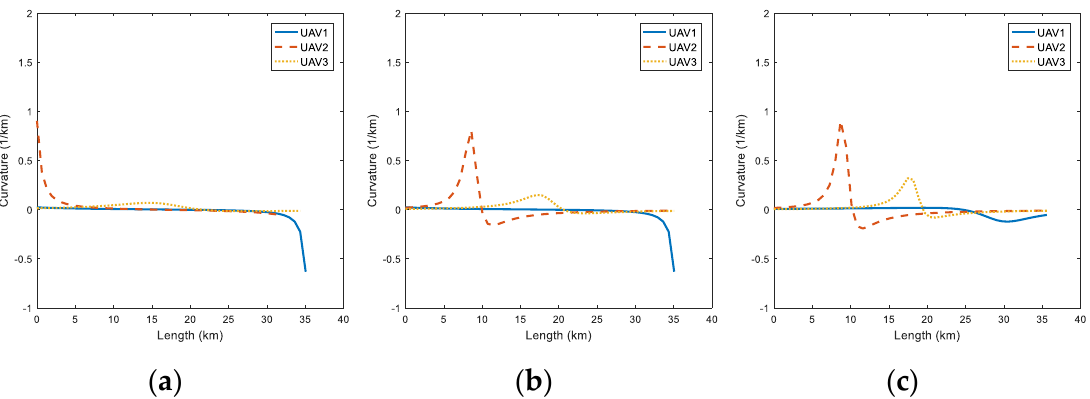
Figure 5. Curvature variations with respect to path length. (a) Produced by DCPSO without cooperation; (b) produced by DCPSO with cooperation; (c) produced by CCGA.